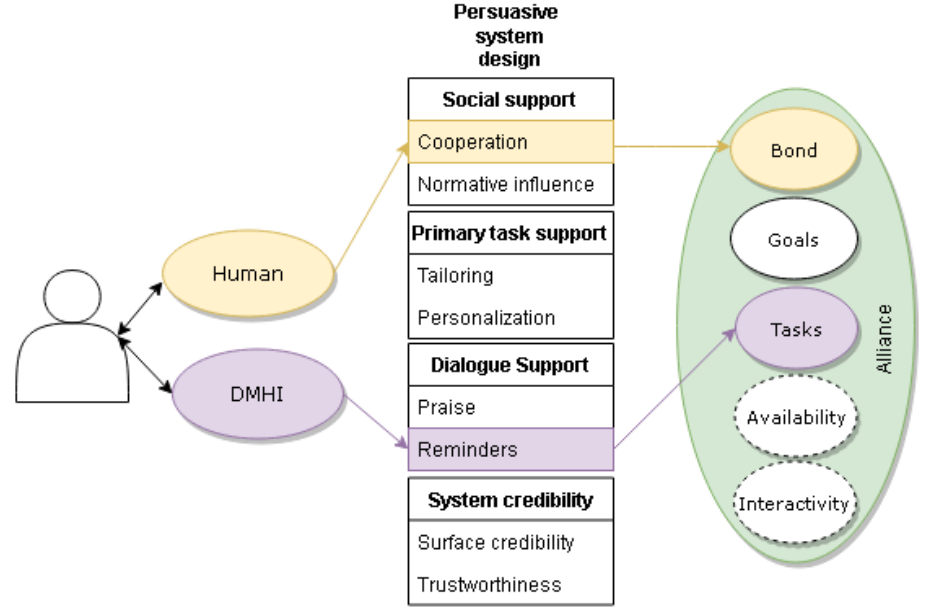
Figure 1. Representation of how specific persuasive systems design features could link to specific domains within the digital therapeutic alliance. DMHI: digital mental health